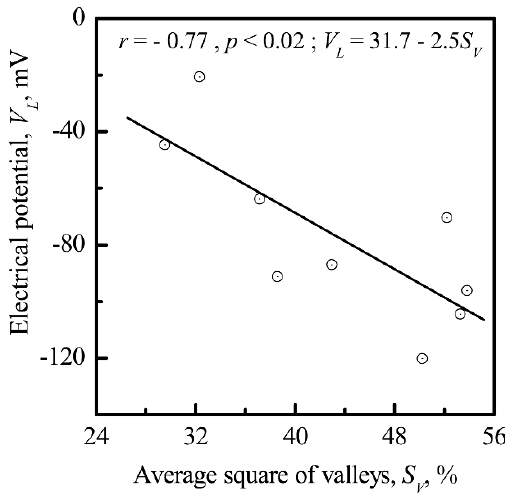
Figure 12. Correlation between the EP ( V L ) and the average area of valleys ( S V ) on the CP surface.